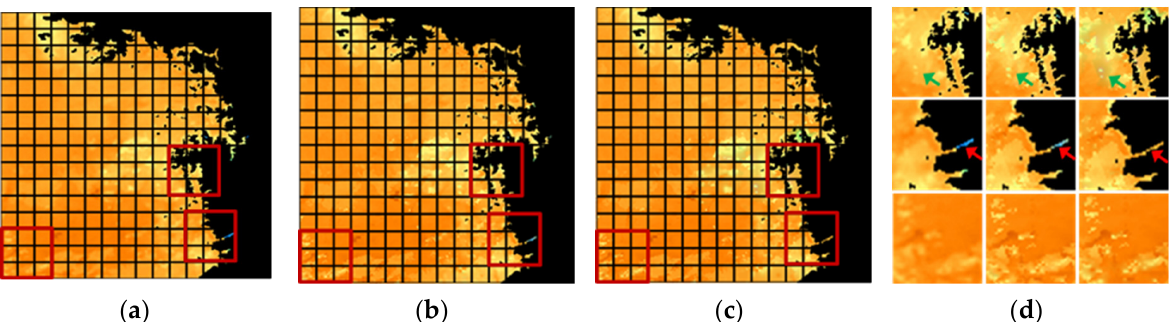
Figure 10. Comparison of temperature restoration between IDW [27] interpolation and GIN model. ( a ) DayMOM (ground- truth) image divided into 16 × 16 patch images, ( b ) restoration result by using GIN, ( c ) restoration result by using IDW interpolation, ( d ) DayMOM image patch (left), restored patch by using GIN (middle), restored patch by using IDW (right) for three local regions enclosed by red boxes in ( a – c ), respectively.